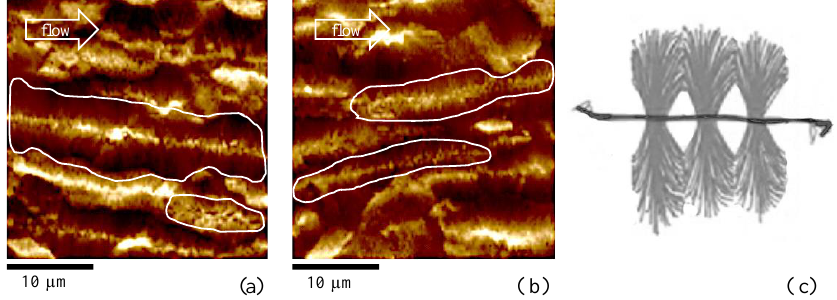
Figure 9. AFM height maps of the samples ( a ) 80-07; and ( b ) 150-07, at 0.50 mm from the sample surface; ( c ) Sketch of cylindritic structure adapted from An et al [34].